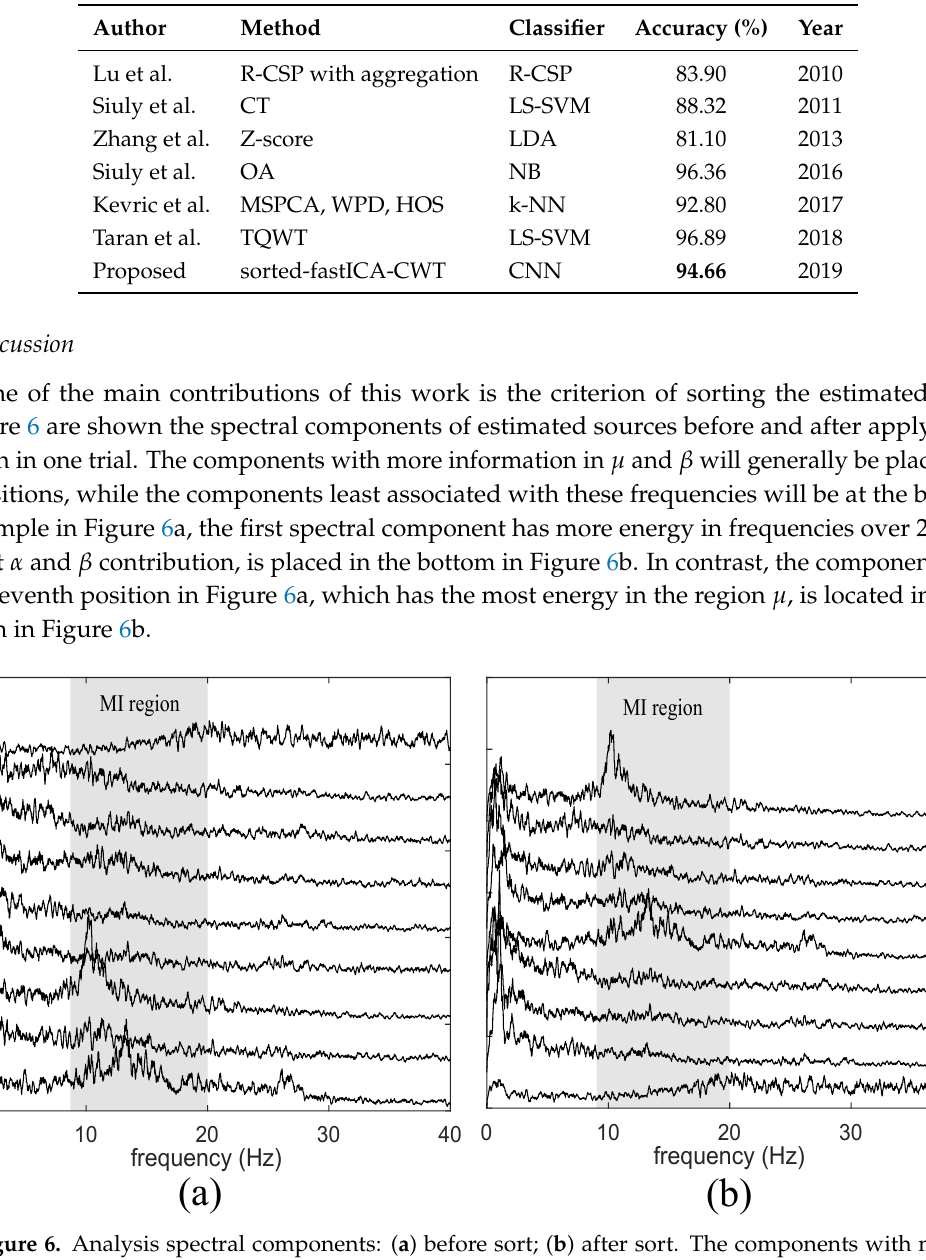
Table 3. Comparison with other works using the IVa of BCI competition III dataset.